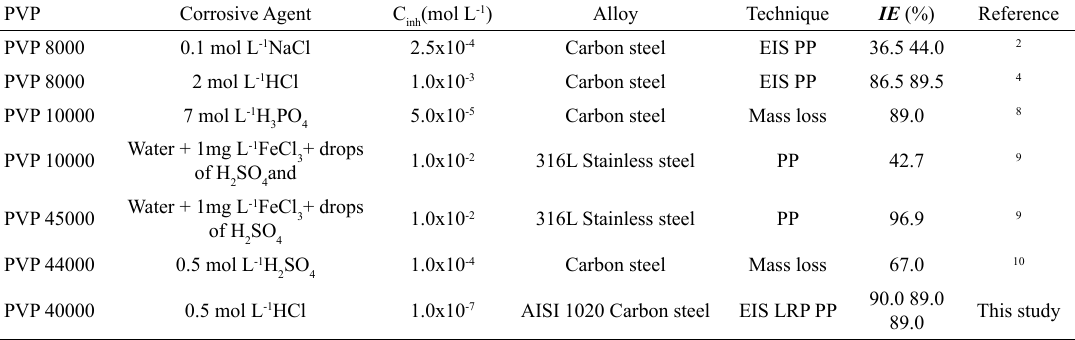
Table 4.. Experimental data of inhibition efficiency, corrosive medium, concentration, metal-type and technique reported in literature about the PVP polymer. PVP Corrosive